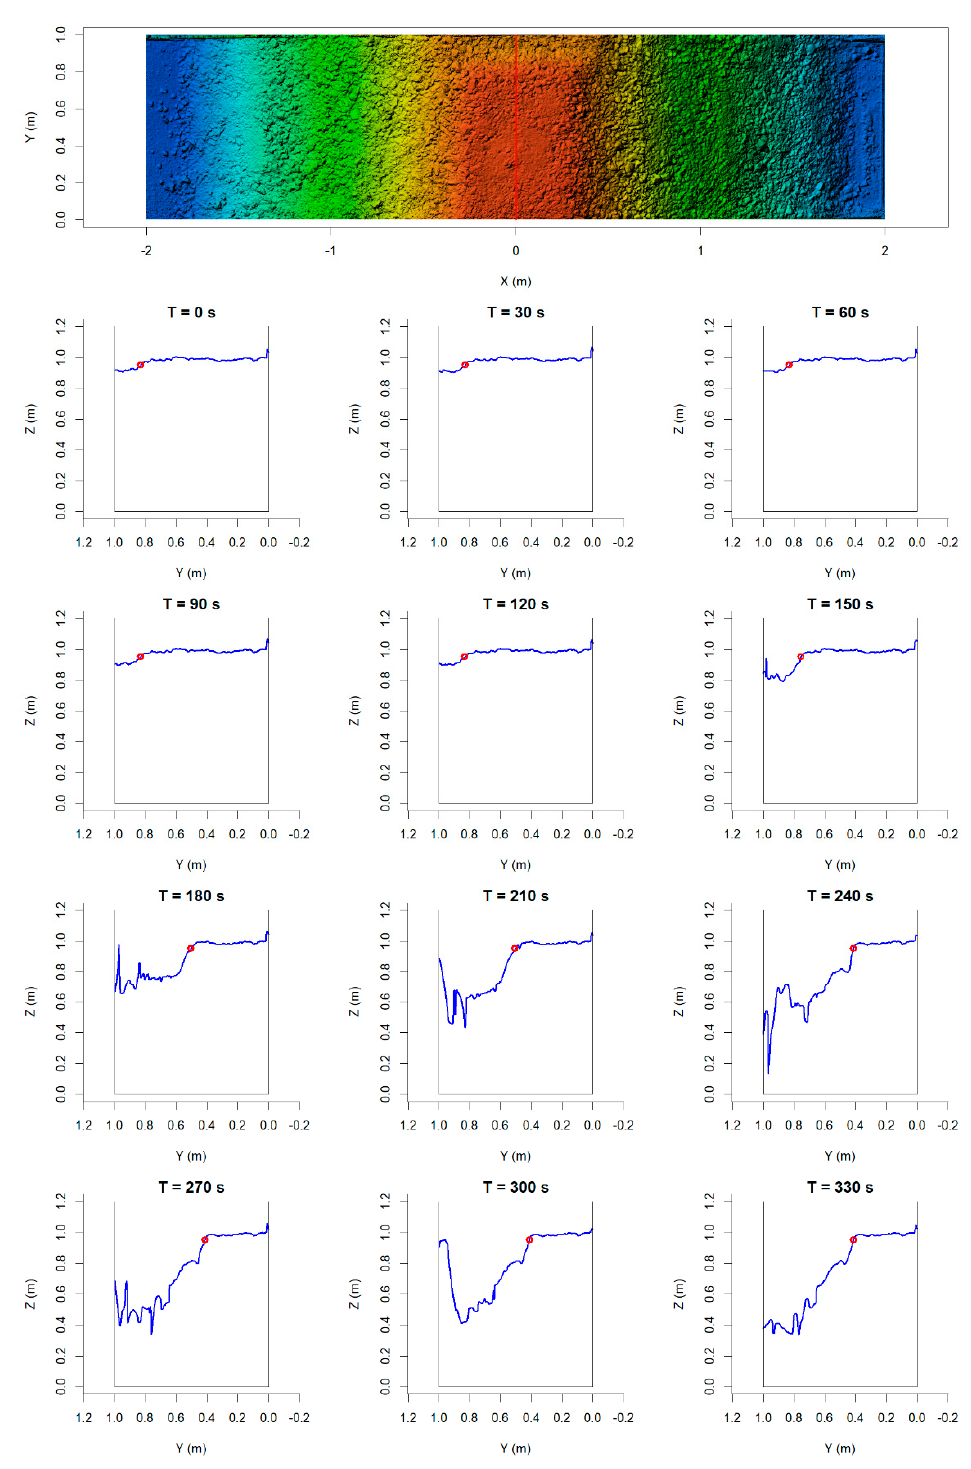
Figure A4. Cross-section profiles for X = 0 m (centre line) extracted from U4 dynamic 3D model; T = 0 s is immediately before initial observed erosion at downstream edge of crest; red circle indicates breach edge as used in further analyses.